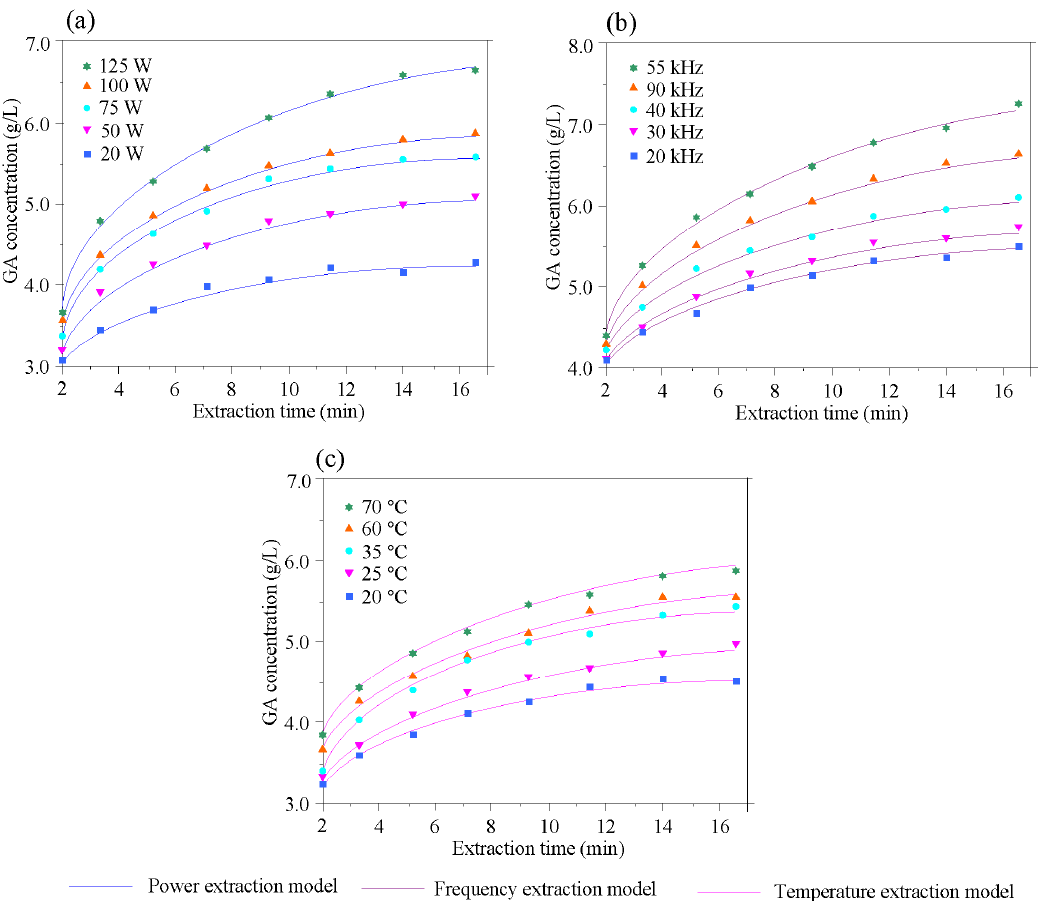
Figure 10. Comparison between prediction values of extraction models and experimental values for the extraction glycyrrhizic acid: ( a ) power extraction model at f = 55kHz, T = 25°C; ( b ) frequency extraction model at P = 125 W, T = 25 °C; ( c ) temperature extraction model at P = 125 W, f = 55 kHz.